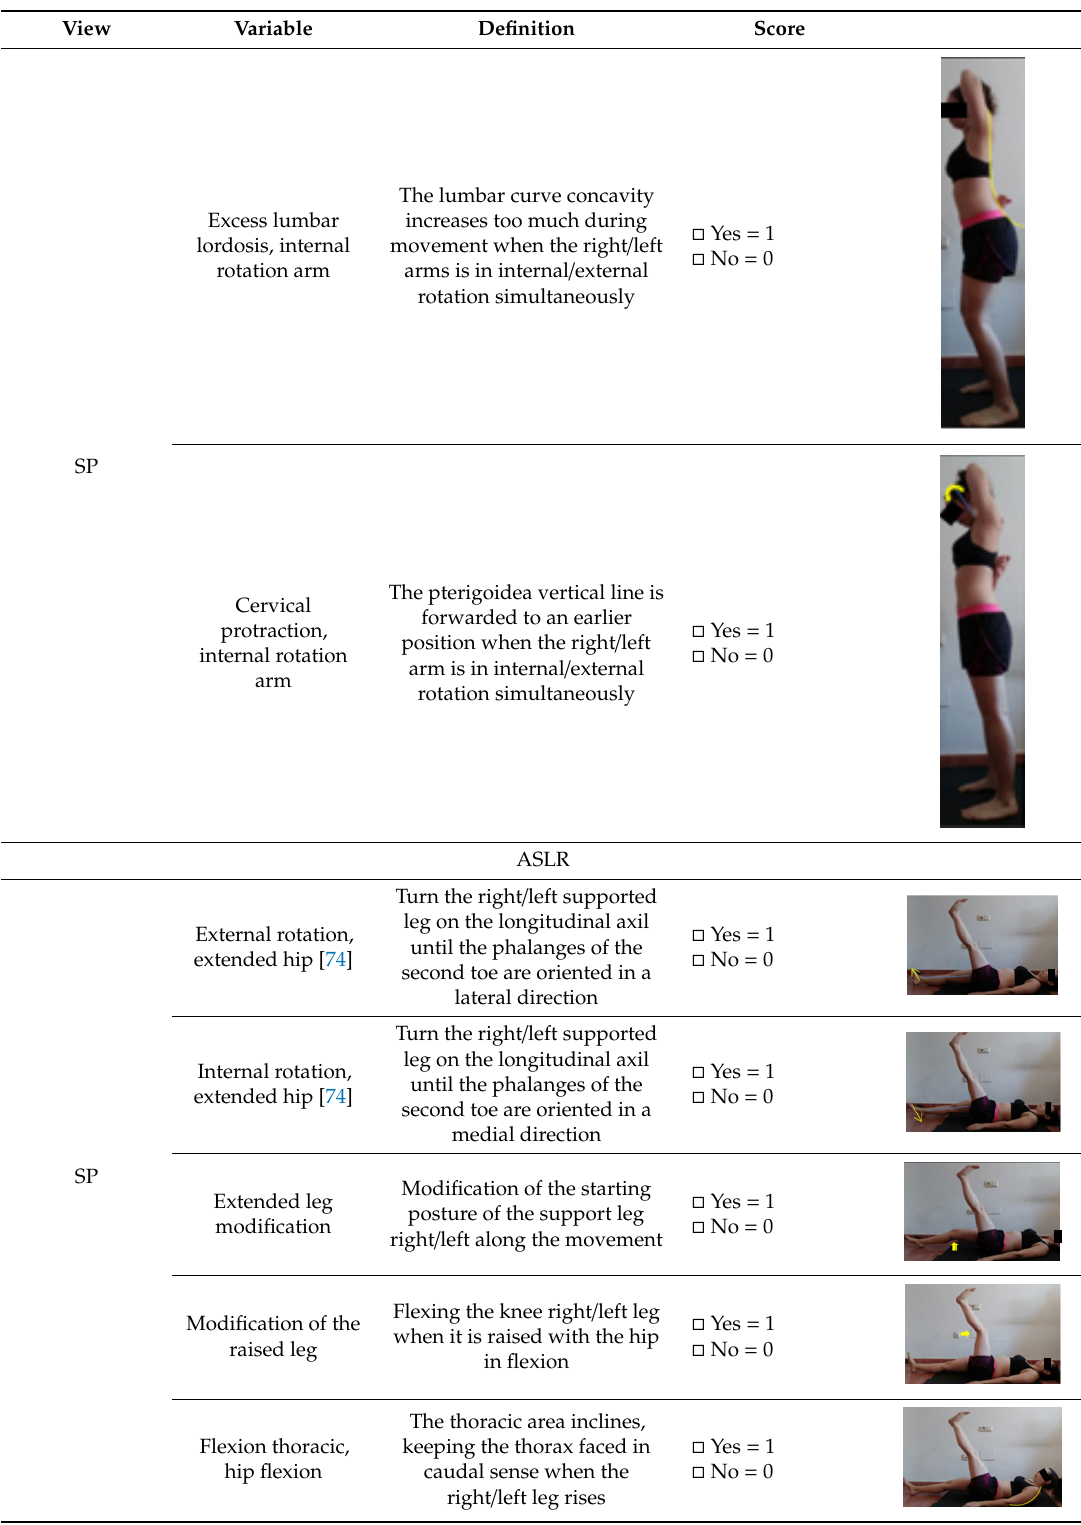
External rotation, extended hip [74]